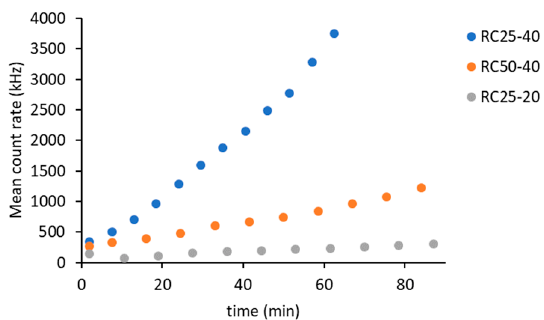
Figure 1. Time evolution of the scattered intensity measured for the studied RF mixtures.